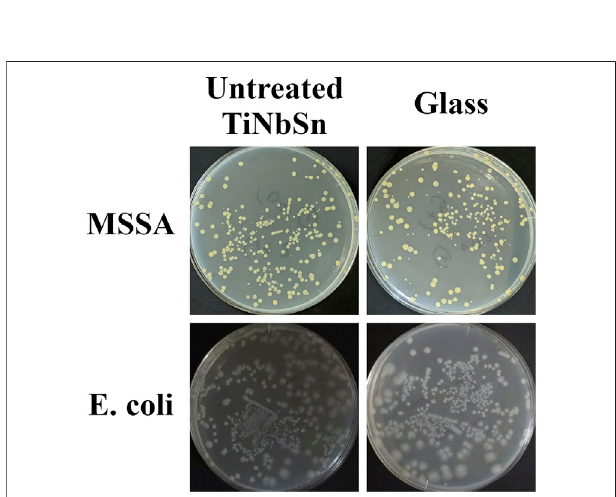
FIGURE 10 | The comparison of logarithmic reduction values in each specimen. The sample size is n = 5 in each group. The one-way ANOVA post hoc by Steel-Dwass test was used for statistical evaluation. *: p < 0.05 ANOVA: analysis of variance.